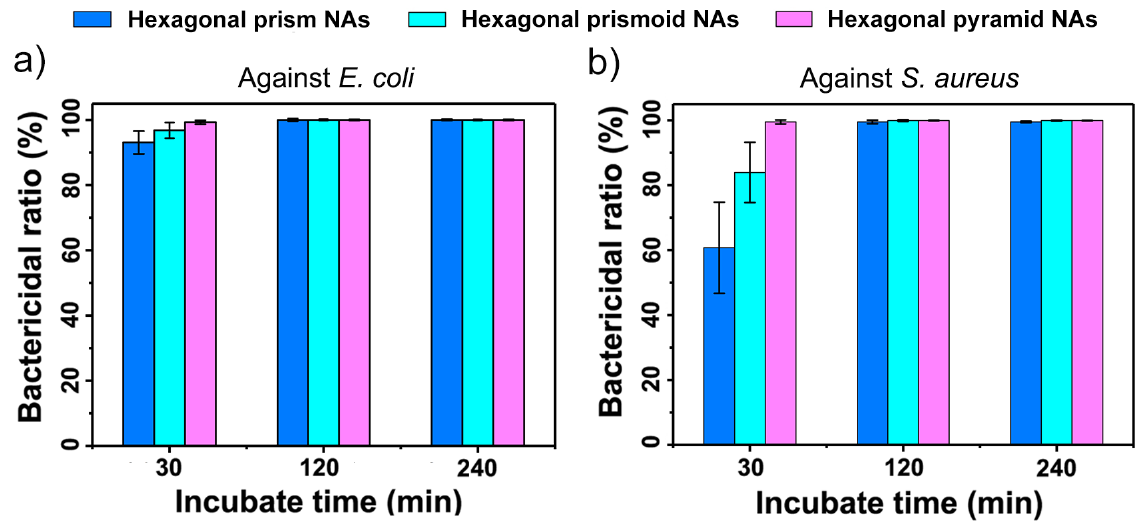
Figure 3: The bactericidal ratios of three ZnO NAs in darkness with the incubation time varying from 30-120 min a) against E. coli and b) against S. aureus